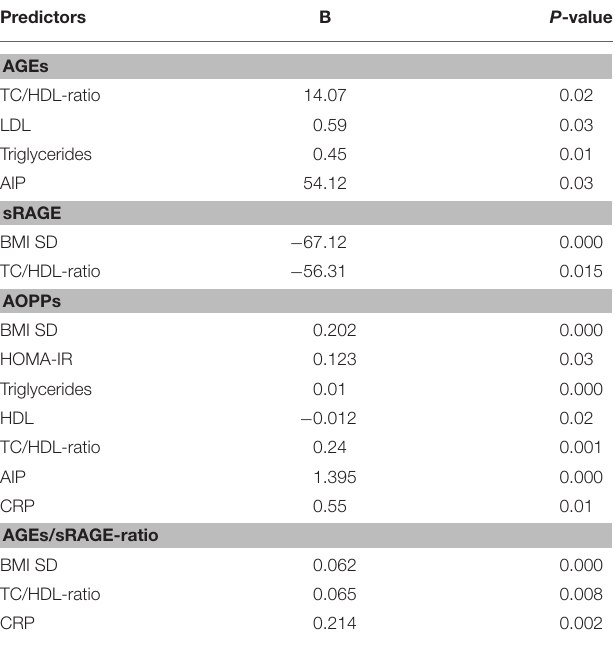
TABLE 3 | Statistically significant associations at univariate linear regression analysis.